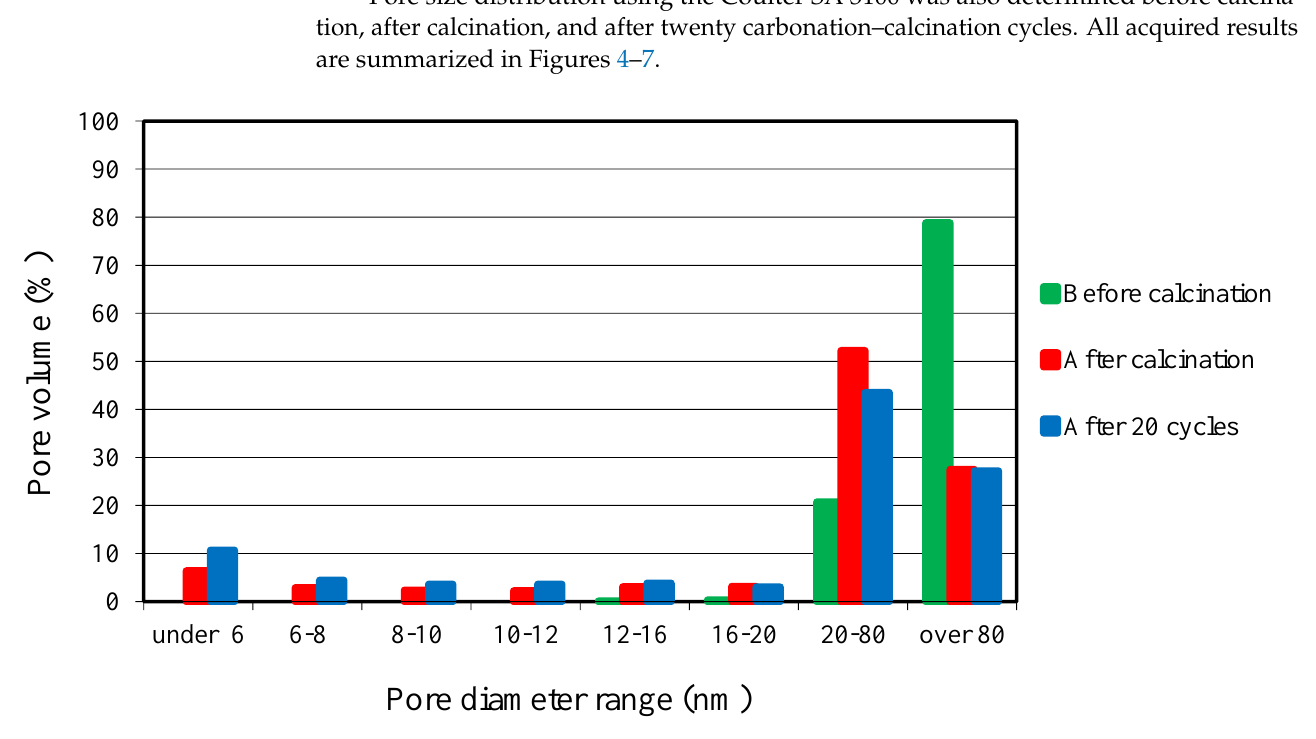
Figure 4. A comparison of Libotín limestone pore size distribution before calcination, after calcination, and after 20 cycles.